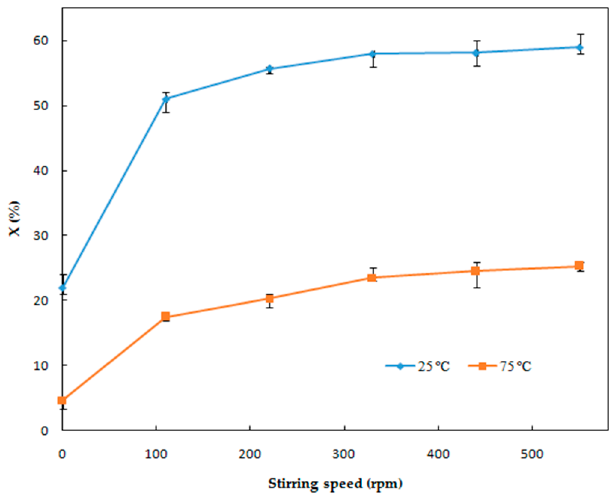
Figure 5. Effect of stirring speed on the dissolution of LiCoO 2 .